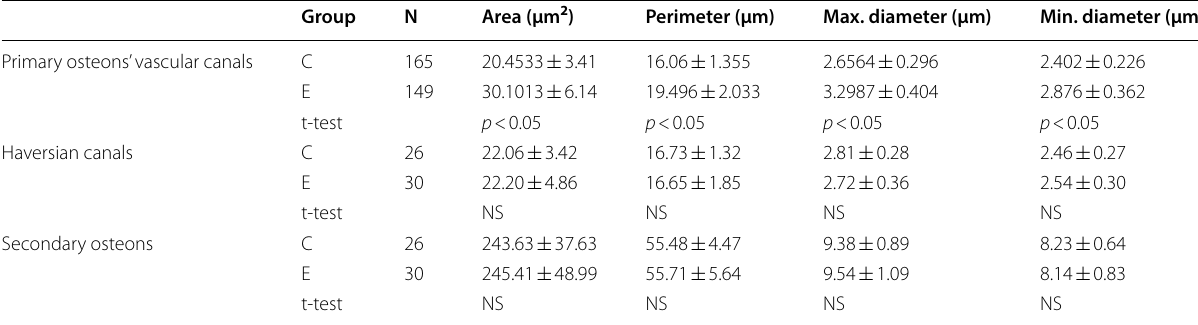
N number of measured structures, NS non-significant differences Table 2 Data of quantitative 3D analysis of compact bone tissue in mice from both groups